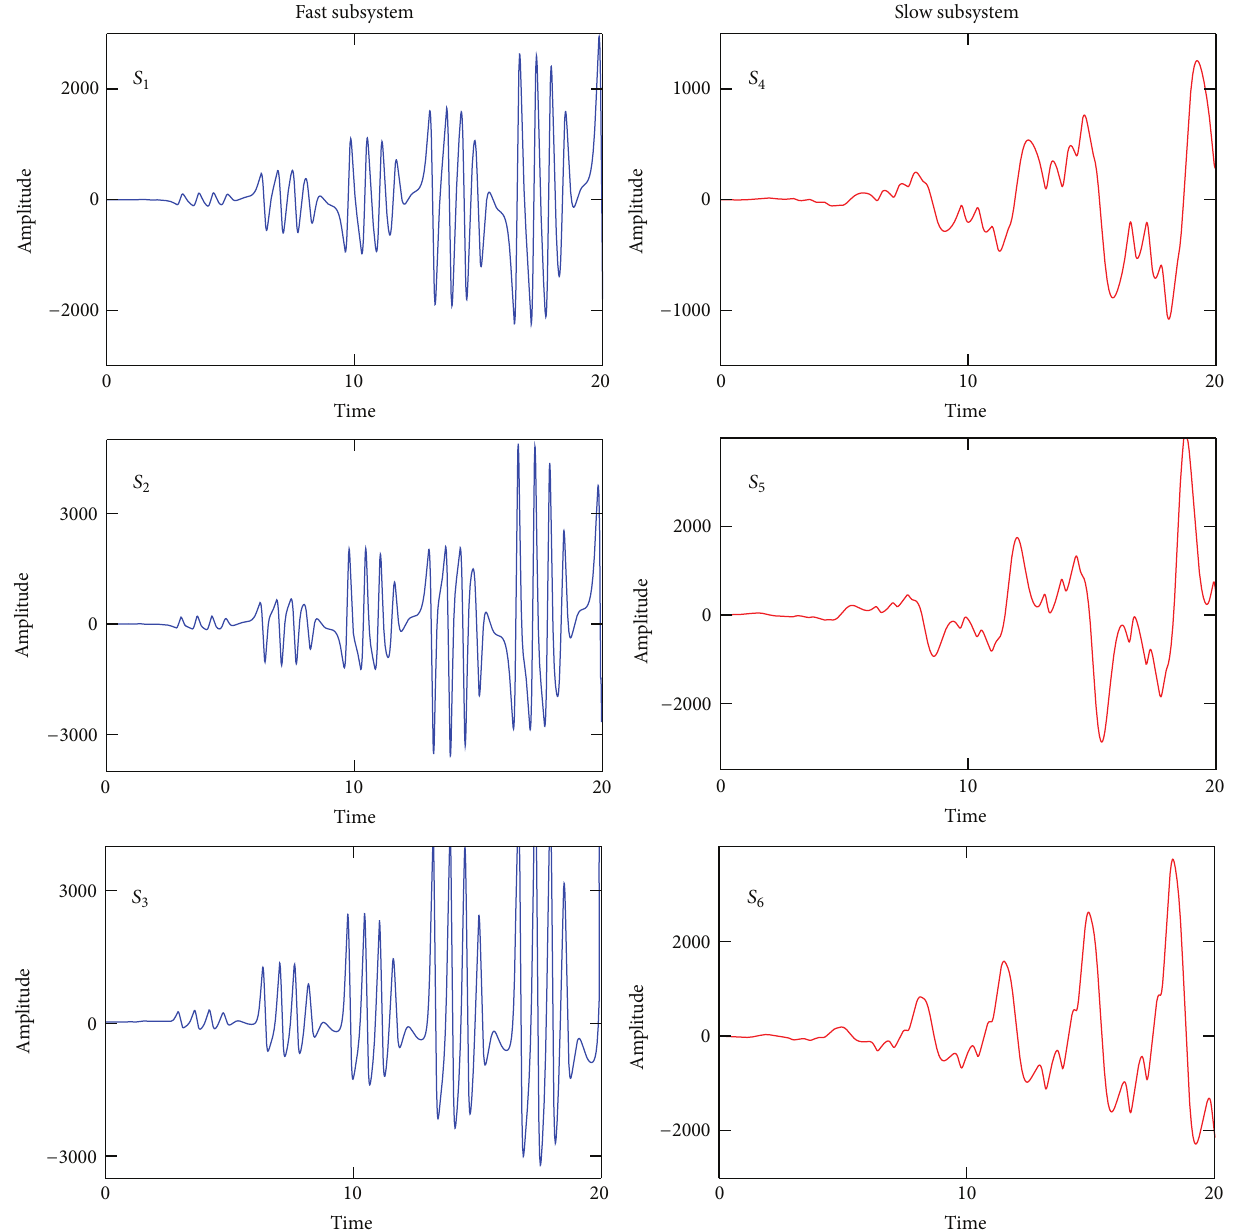
Figure 4: Time dynamics of sensitivity functions with respect to parameter 𝑐 on the time interval [0,20] for 𝑐 0 = 0.9 .